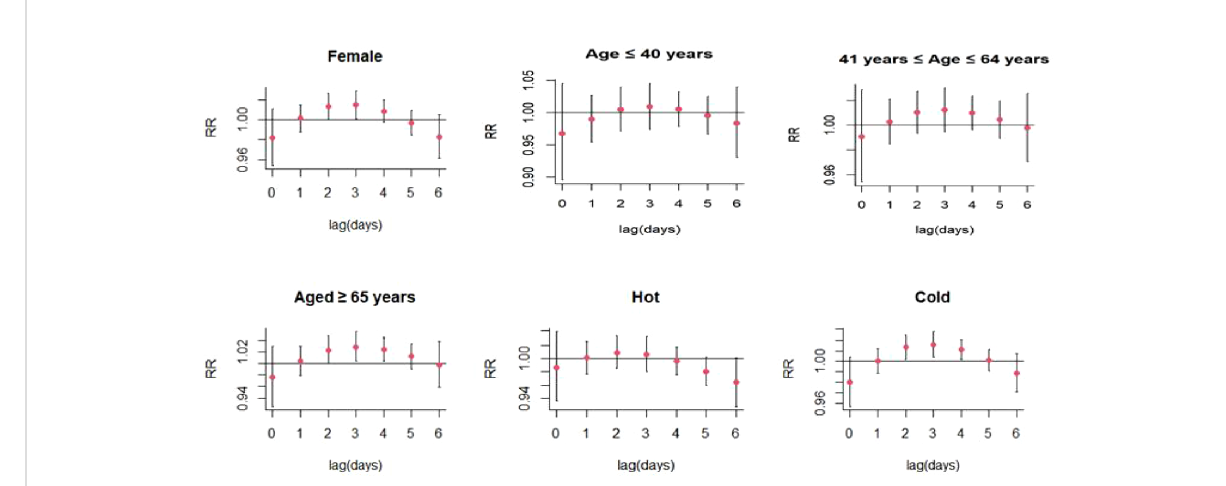
FIGURE 6 Lag-speci fi c relative risks (95% CI) of SS hospitalizations per 10 unit increase in the daily concentrations of PM 2.5 in model strati fi ed by age, gender, and